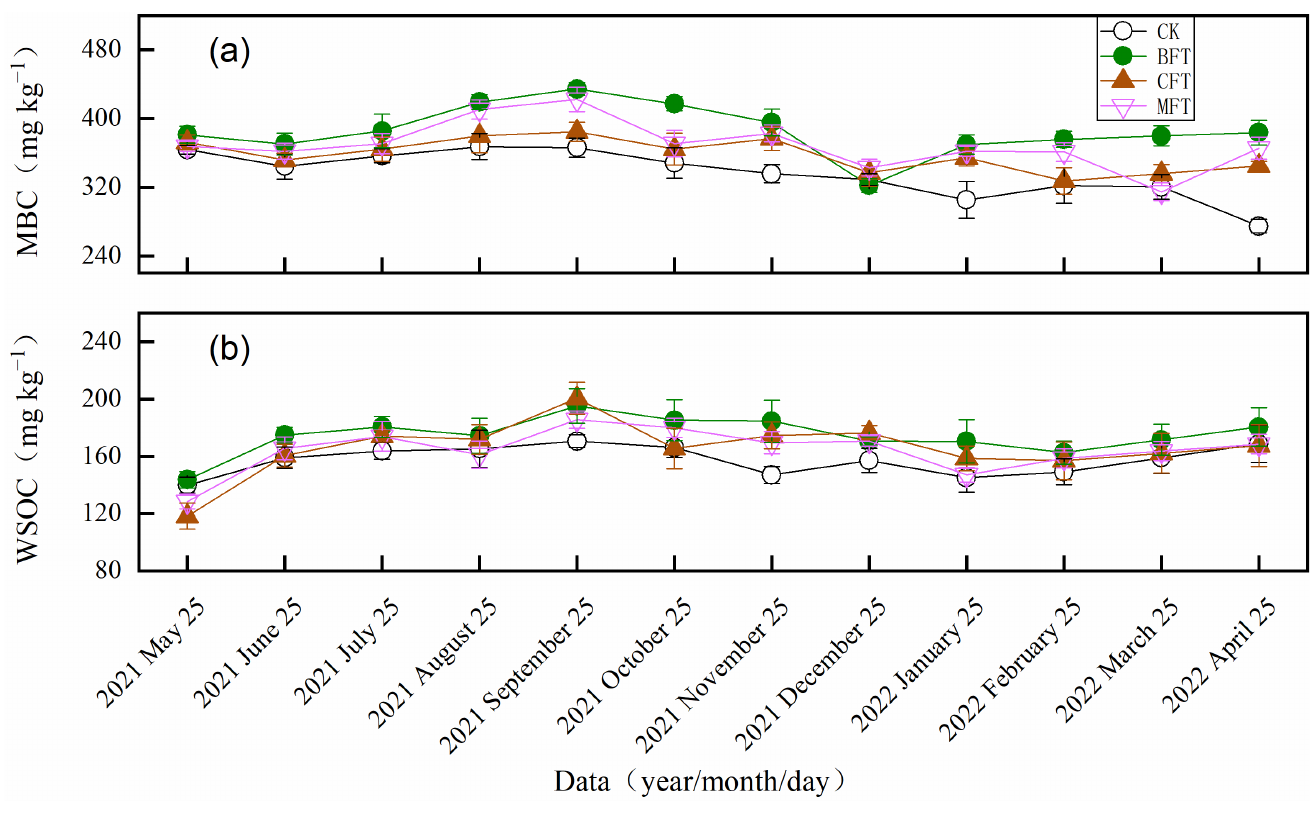
Figure 6. Effects of various fertilization strategies on soil ( a ) microbial biomass C (MBC) and soil ( b ) water-soluble organic C (WSOC) concentration in the Pleioblastus amarus plantation. The standard deviation is indicated by vertical bars.